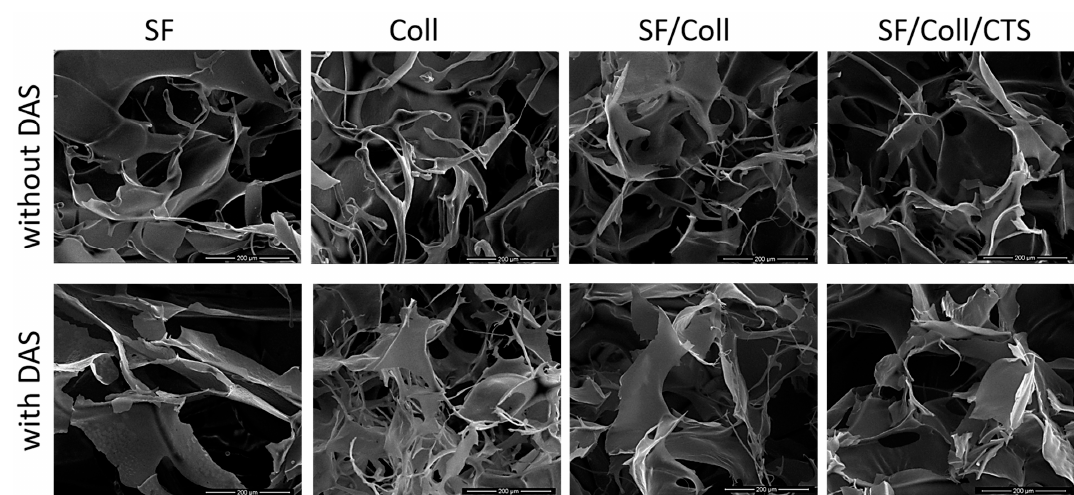
Figure 2. SEM images of every scaffolds with scale bar 200 µm.